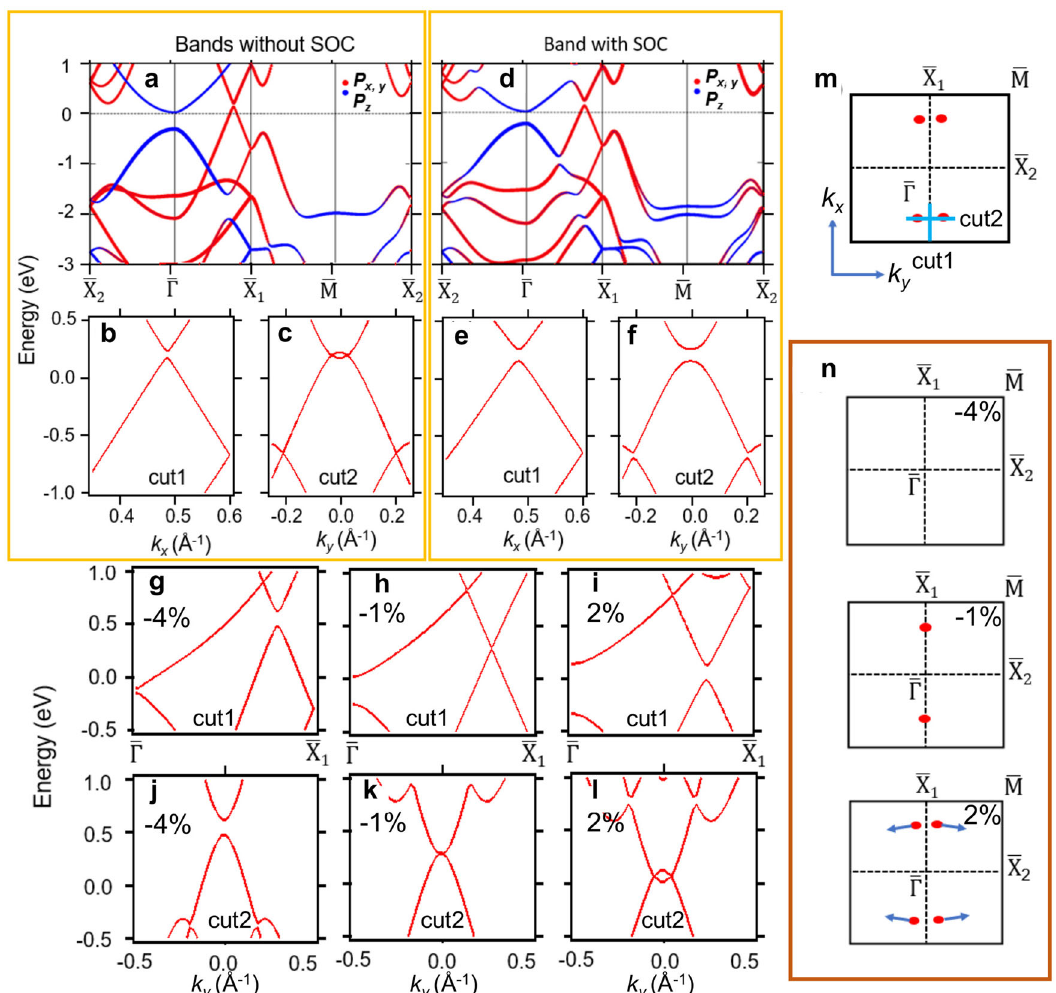
Fig. 2 | Calculated band structure of 1L α -Sb. a The band structure of 1L α -Sb calculatedwithouttheinclusionofSOC.Thebandsarecoloredaccordingtotheir orbital components. b , c The calculated band dispersion along 'cut1' and 'cut2' (marked in m ) without the inclusion of SOC. d – f Same as a-c , but calculated with the inclusion of SOC. g – l Band structure (without SOC) of 1L α -Sb under uniaxial lattice strains along y -direction. g , j Band dispersion along 'cut1' and 'cut2'